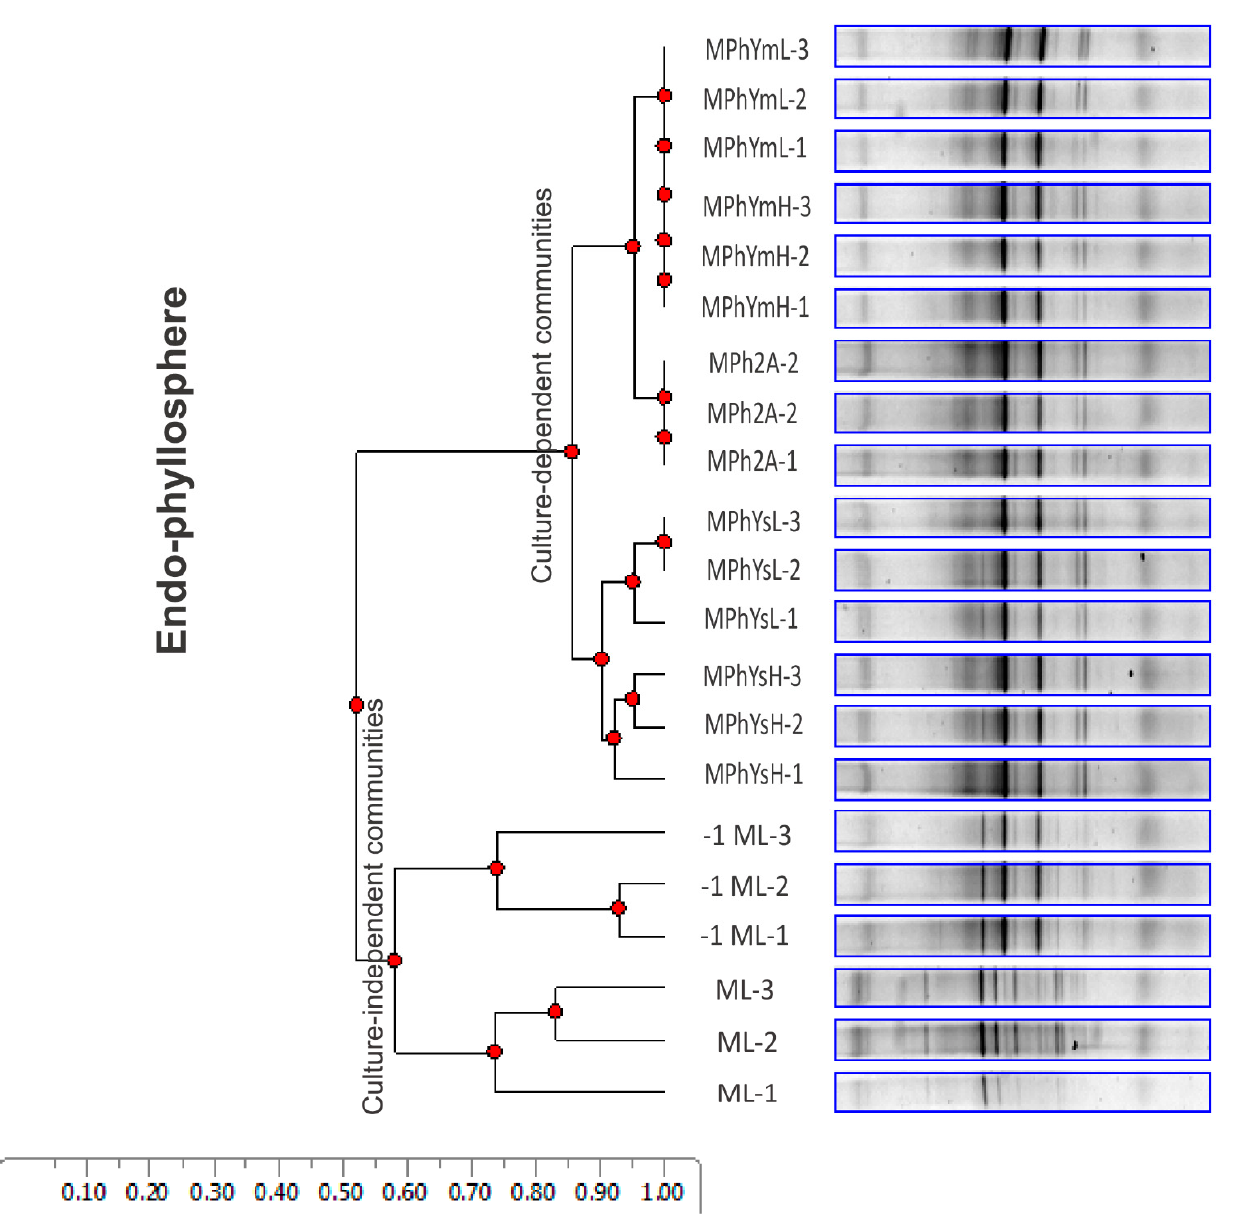
Figure 1. UPGMA clustering of Euclidean distances of DGGE fingerprints of culture-dependent and culture-independent maize endo-phyllosphere bacterial communities. Each culture medium and endo-phyllosphere mother culture is represented by three replicates (plates 1–3). ML, culture- independent mother leaf; MPhYmH, 1ML, 1/10 dilution of culture-independent mother leaf; MPhYmH, culture-dependent on homologous maize broth 25 mL L − 1 ; MPhYmL, culture-dependent on homologous maize broth 5 mL L − 1 ; MPhYsH culture-dependent on heterologous sunflower broth 25 mL L − 1 ; MPhYsL, culture-dependent on heterologous sunflower broth 5 mL L − 1 ; MPh2A, culture-dependent of R2A culture